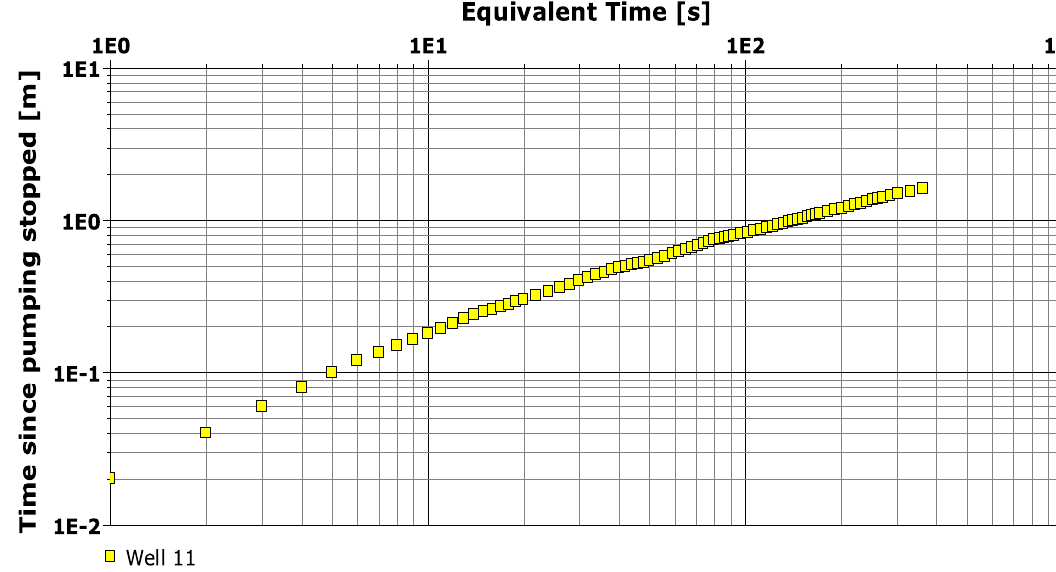
Fig. 16 Plotting of recovery rate of well-11 using aquifer mapping